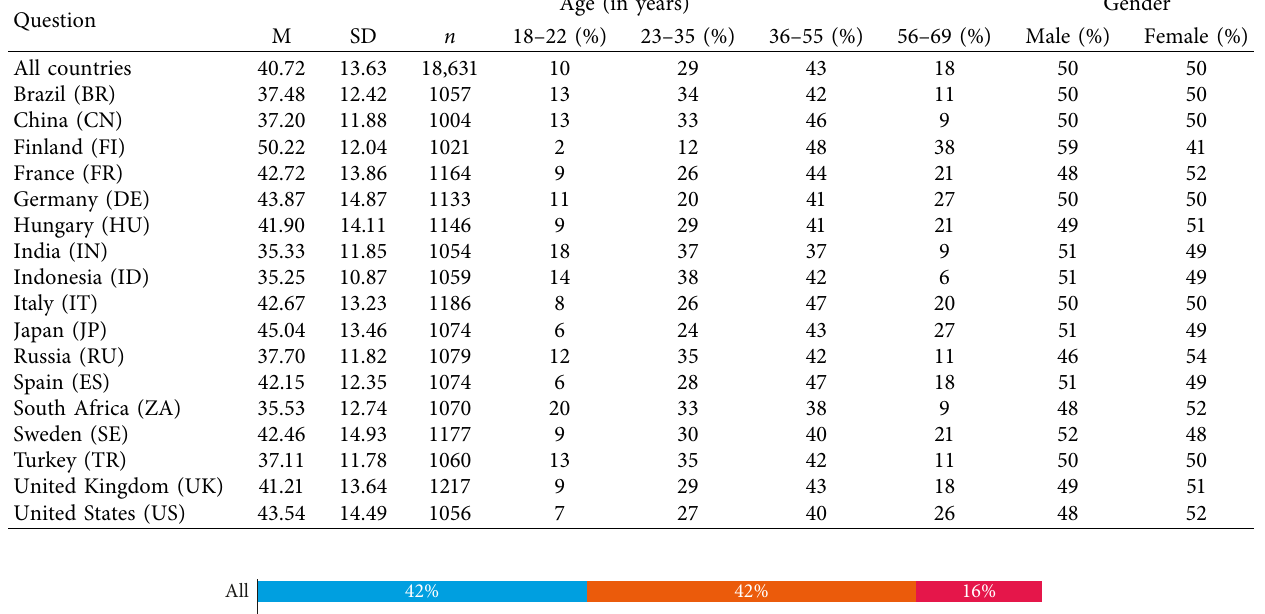
Table 1: Respondents’ age and gender (i.e., M � mean, SD � standard deviation, and n � number of respondents, relative frequencies). Question